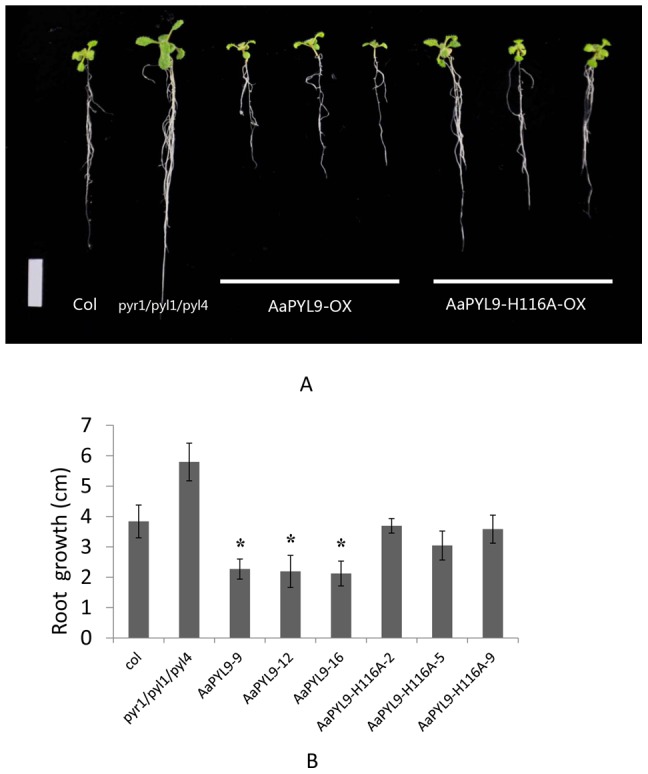
ABA hypersensitive inhibition of root growth in 35S::AaPYL9 transgenic Arabidopsis.A: Growth of Col-0, pyr1/pyl1/pyl4, three independent 35S::AaPYL9 lines (9, 12, 16) and three independent 35S::AaPYL9-H116A lines (2, 5, 9) in medium (MS) supplemented with 5 µM ABA. Photographs of representative seedlings 7 d after the transfer of 5-d-old seedlings from MS to plates supplemented with 5 µM ABA. Bar = 1 cm. B: Statistic analysis of root length in medium (MS) supplemented with 5 µM ABA. Data are averages ± SE from three independent experiments (n = 30 seeds per experiment). *P<0.01 (Student's t test) when comparing data for each genotype versus the wild-type under the same conditions.